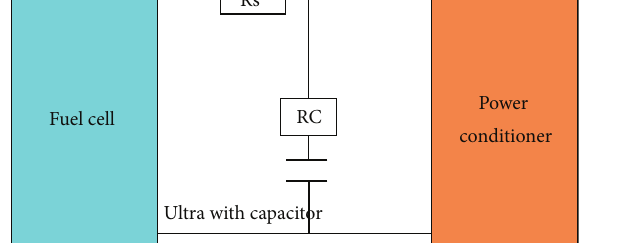
Table 2: Definitions of the symbols used in